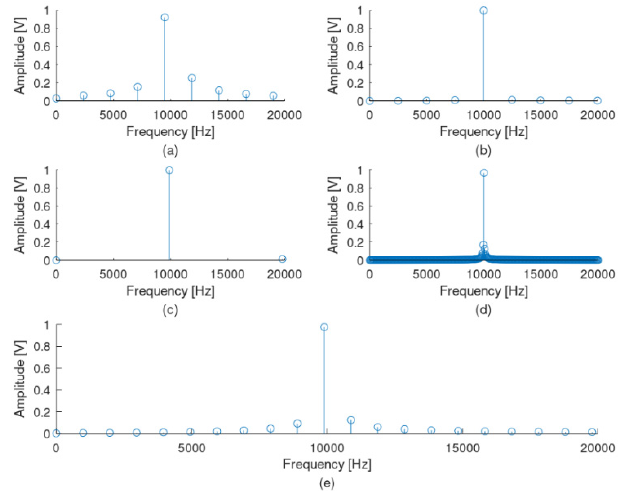
Figure 7. FFT results of the same sine signal at 10 kHz in the frequency domain, when different observation windows at the time domain are used. Observation time interval includes ( a ) four full periods of 10 kHz signal, but it is not an integer multiple of the 10 kHz signal period (0.42 ms); ( b ) exactly four full periods of 10 kHz signal (0.4 ms); ( c ) exactly one full period of 10 kHz signal (0.1 ms); ( d ) exactly ten full periods of 10 kHz signal (1 ms); and ( e ) ten full periods of 10 kHz signal, but it is not an integer multiple of the10 kHz signal period (1.01